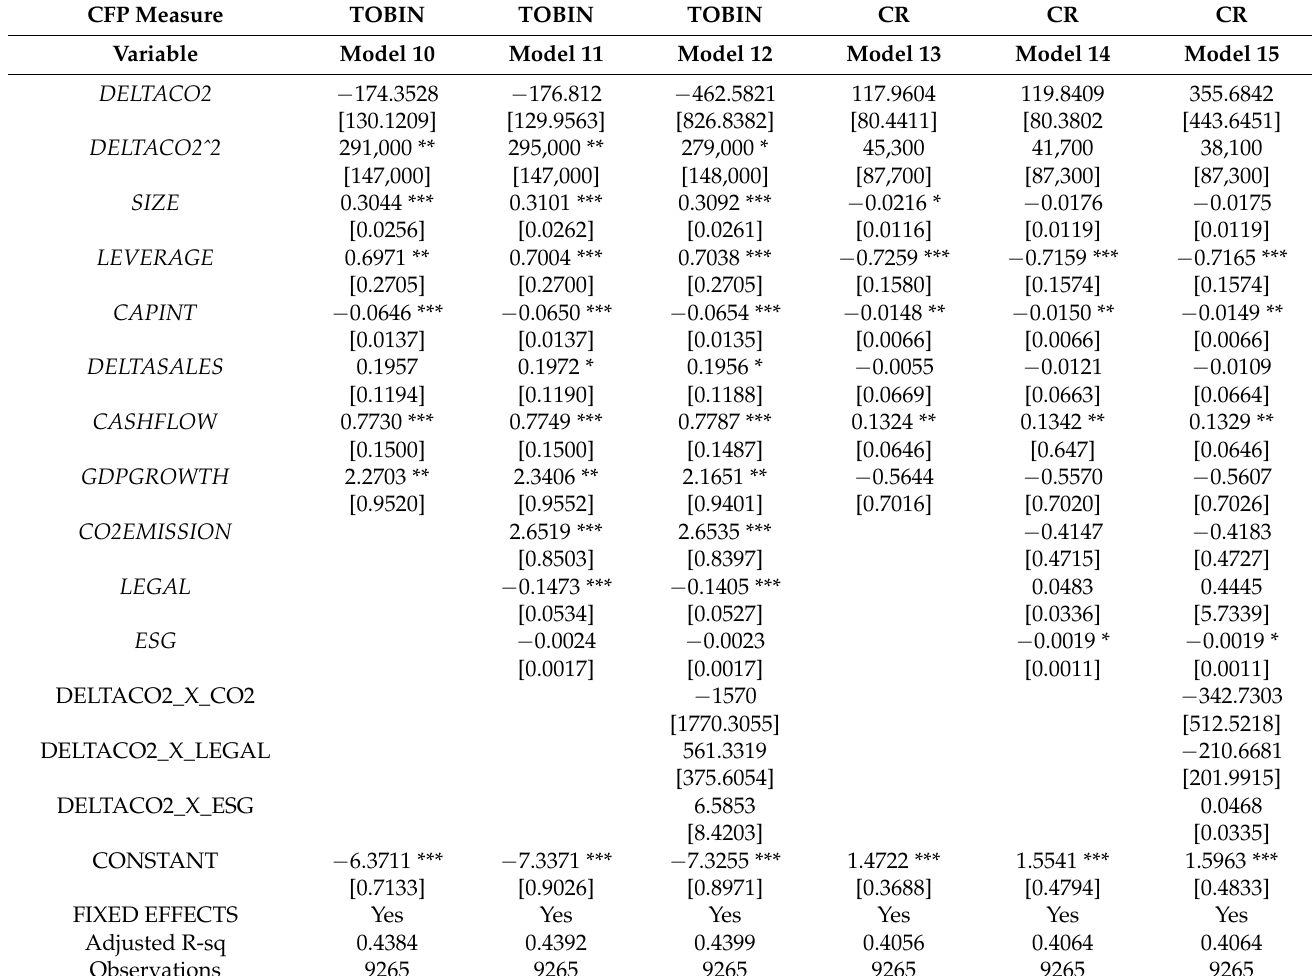
Table 5. Regression analysis on TOBIN and